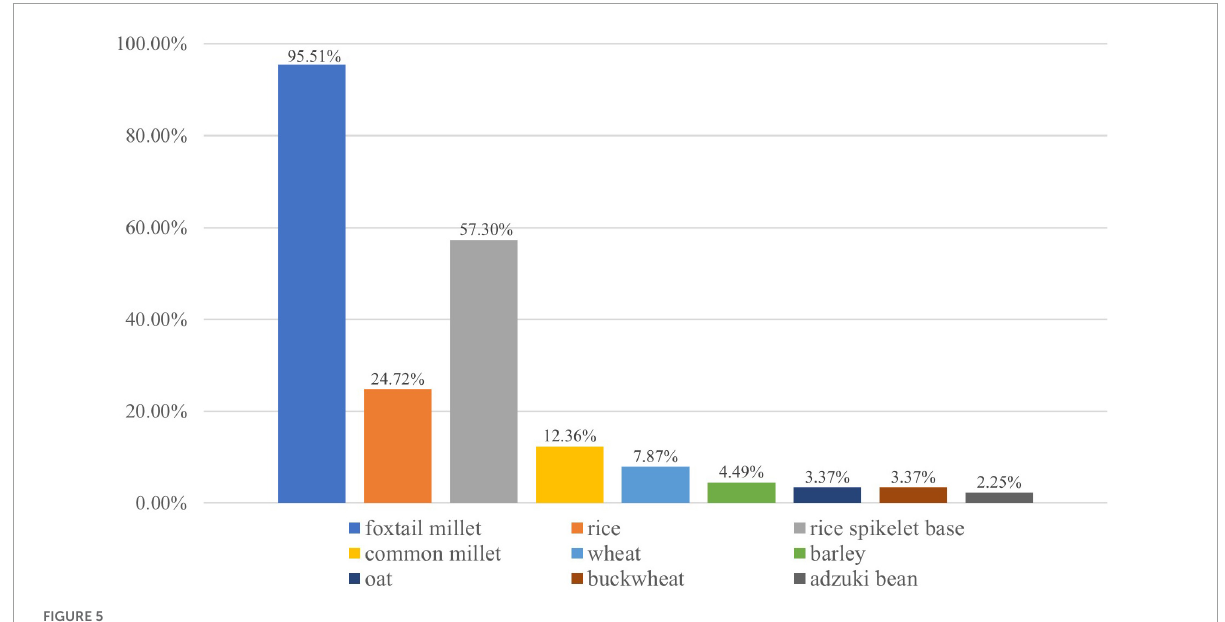
FIGURE5 Ubiquity of crop remains at